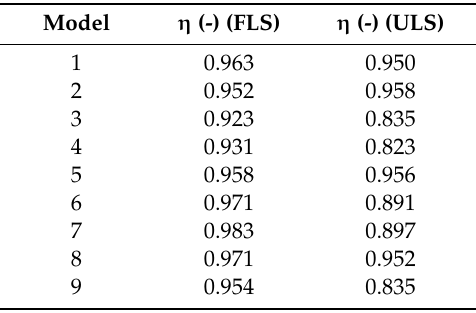
Table A1. Accuracy metric η for di ff erence between 3D FE and 1D Calibrated